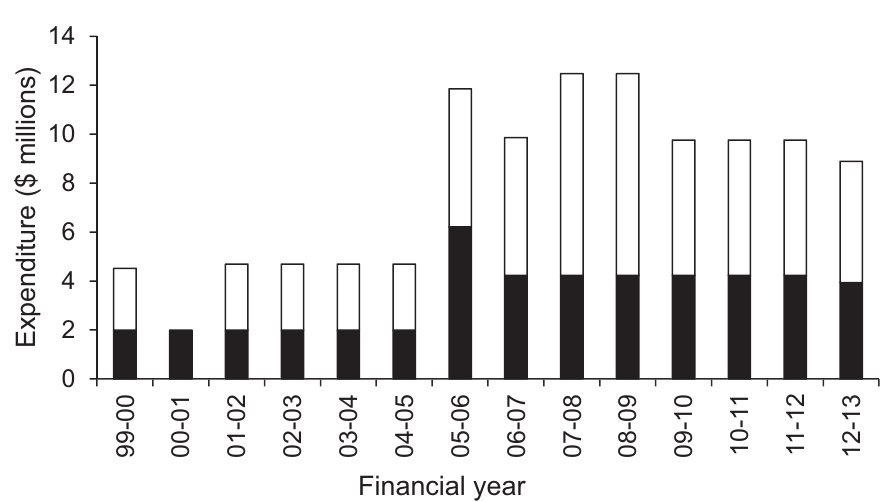
Figure 4. Funding (unadjusted for inflation) supplied to Cooperative Research Centres (CRC) for scientific research focused on invasive animals (black) and plants (white) per financial year. Note that much of the data are uniform across years because yearly data were calculated by averaging the total funding figure of each CRC over its lifespan.